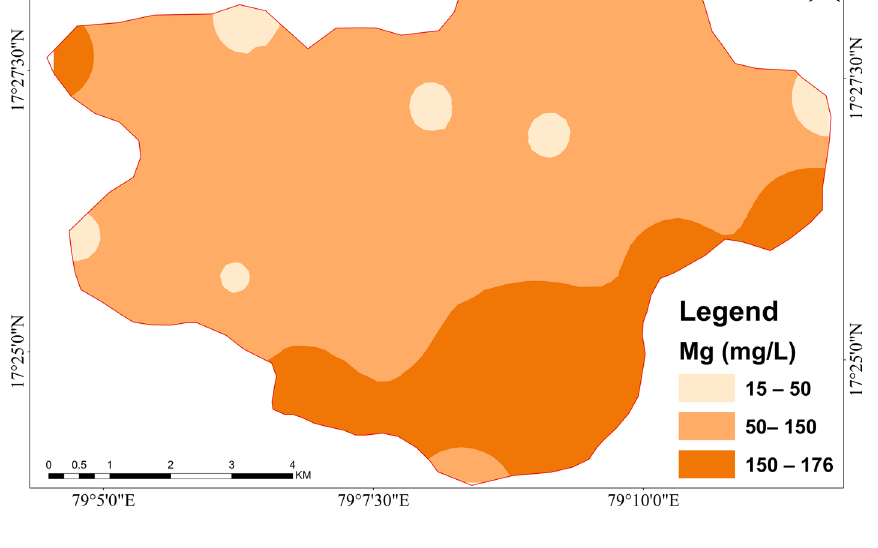
Fig. 9 Spatial distribution map of Mg 2+ in Mothkur region, Telangana State, South India